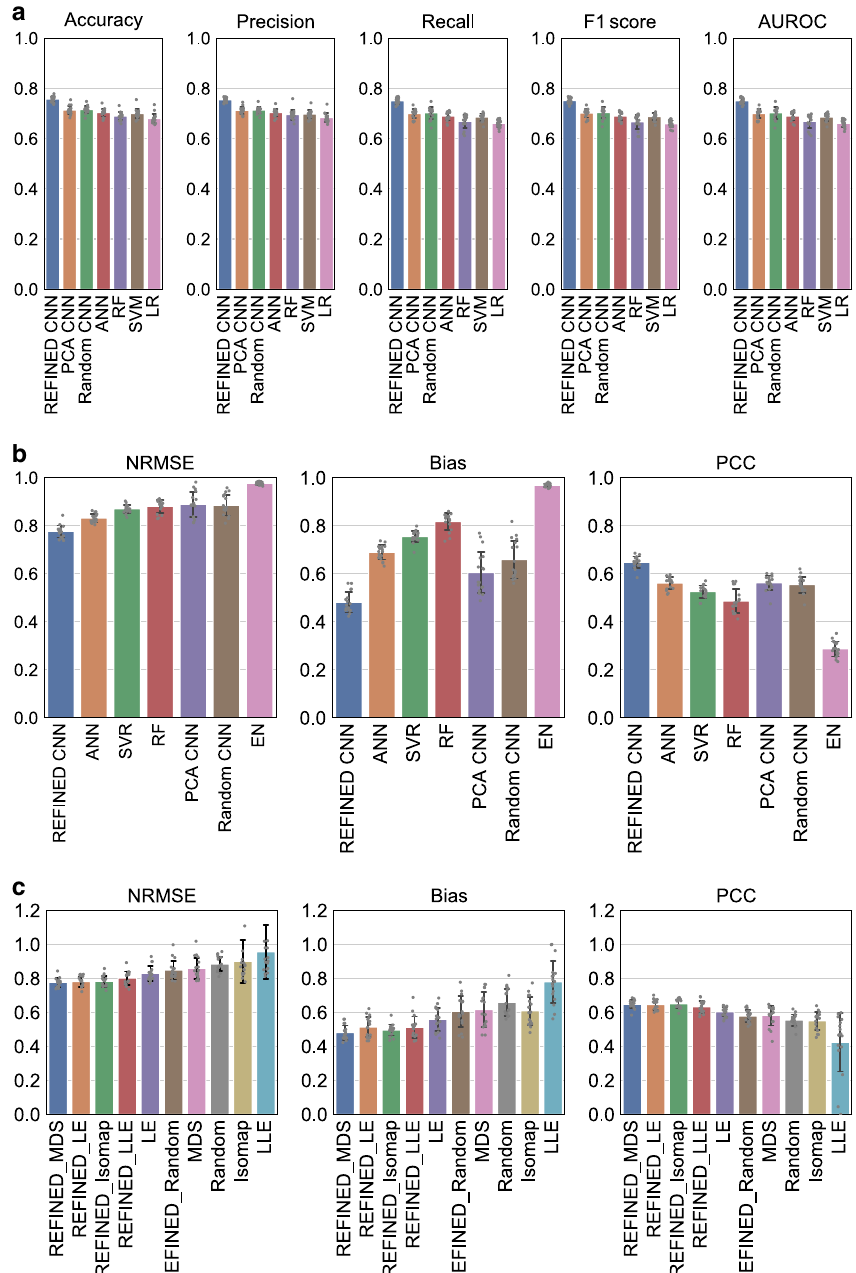
Fig. 3 Comparative performance of REFINED-CNN for the NCI60 dataset. The predictive model associated with each bar is de fi ned under it. a Summary of REFINED-CNN classi fi er performance compared to six other classi fi ers for all 17 cell lines. b Summary of REFINED-CNN performance compared to six other regression models for all 17 cell lines. c Summary of REFINED ablation study results on the regression task where REFINED_MDS represents our proposed